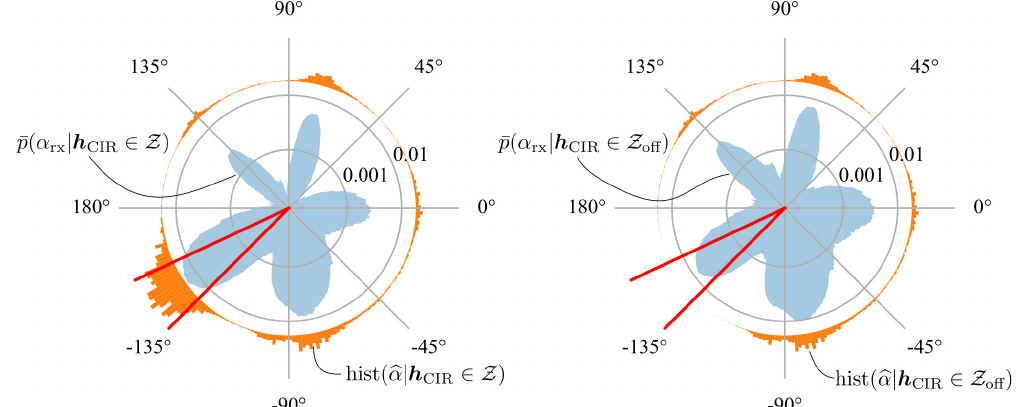
Figure 7. On the left, the averaged, multimodal probability distribution predicted by the neural network is shown in blue for CIR measurements obtained with AOA in the range of − 135 ◦ to − 155 ◦ (see Equations (9) and (10)). Also the histogram of the corresponding maximum a-posteriori AOA estimates is shown in orange. On the right, the averaged probability distribution is shown for CIR measurements obtained in the same range, but whose corresponding maximum a-posteriori AOA estimate also deviates by more than 30 ◦ (see Equations (11) and